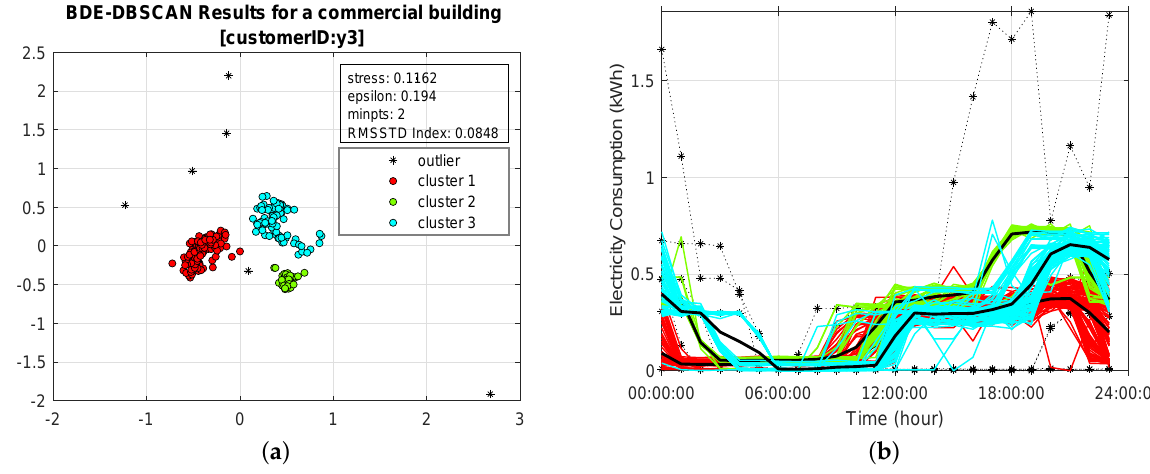
Figure 4. Non-classical multidimensional scaling representation ( a ) and daily consumption profiles ( b ) of a commercial building (customer ID: y3 and BDE–DBSCAN clustering